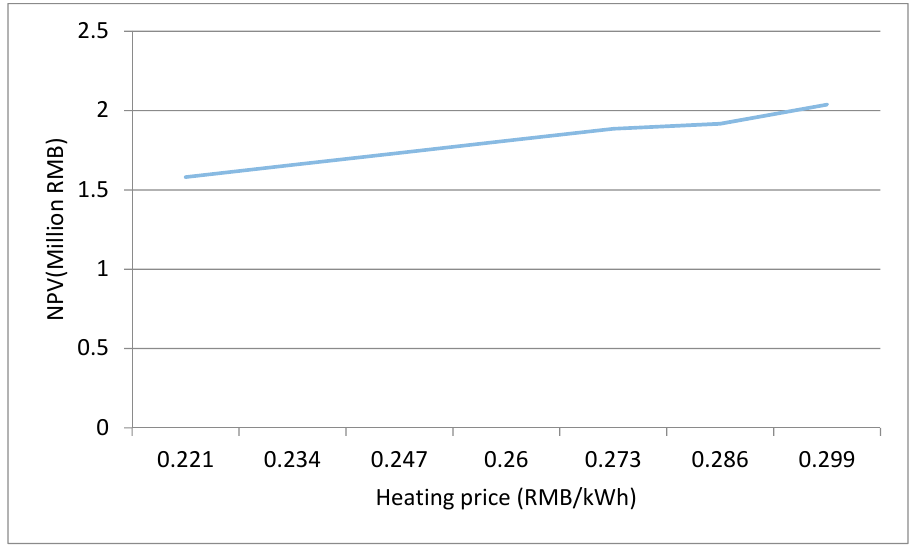
Figure 10. Heating price as a function of NPV.